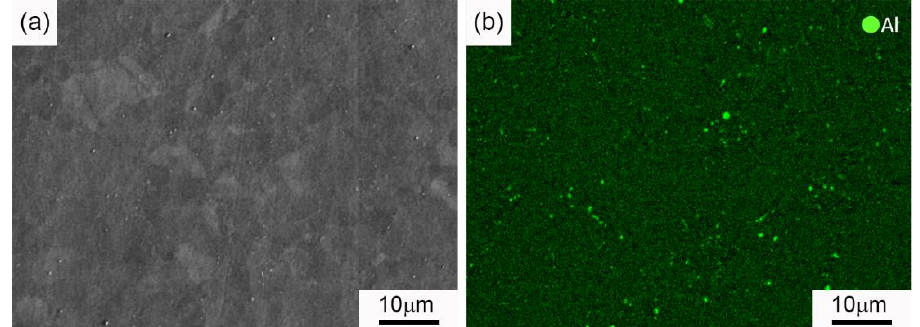
Figure 2. Microstructures of the starting homogenized plate by OM in ( a ) and SEM in ( b ).